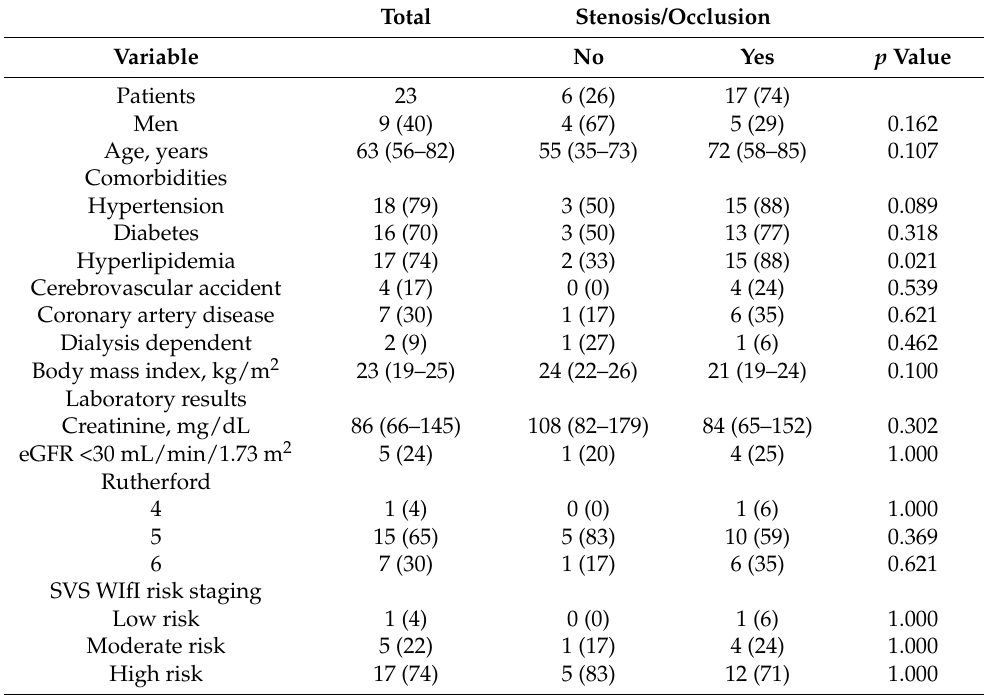
Table 1. Baseline characteristics of included